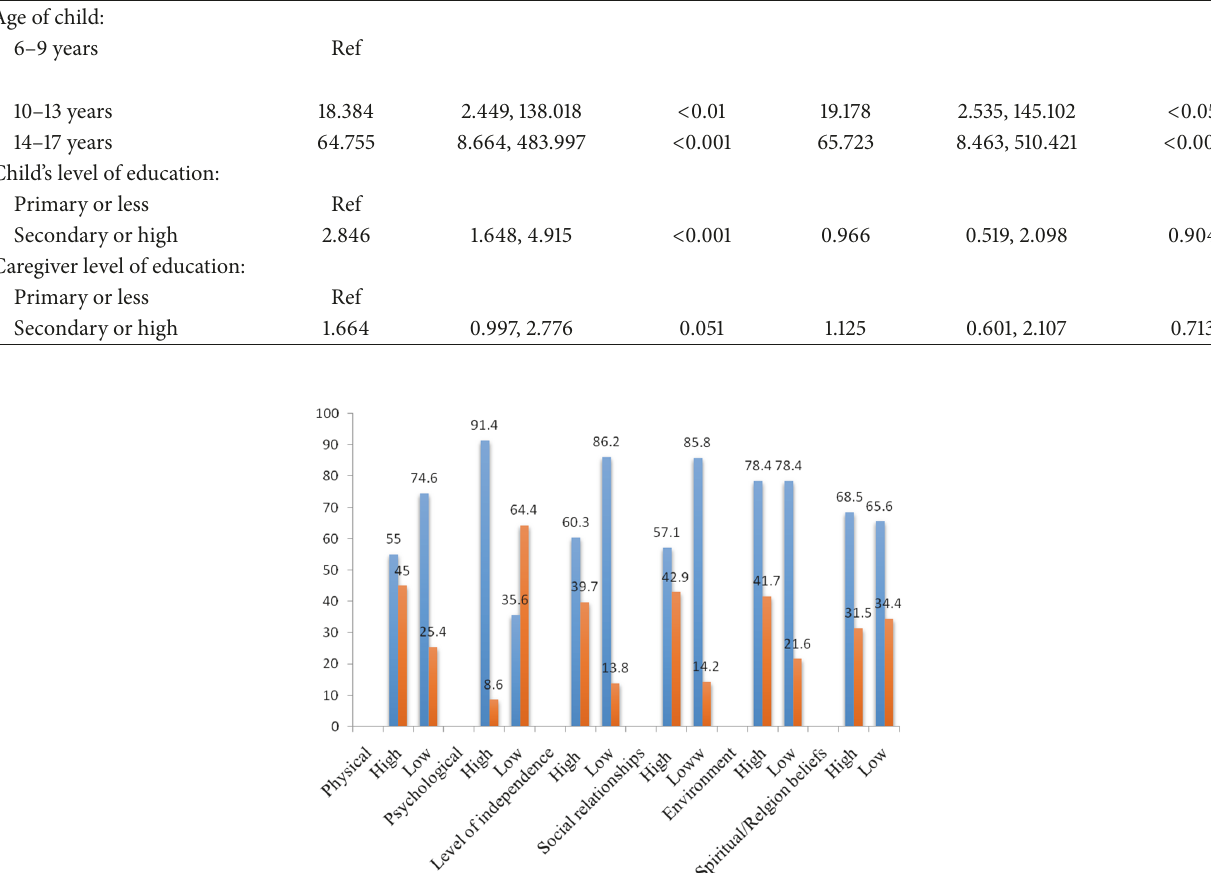
aged between 10 and 13 years and 14 and 17 years had 19 and 66 (AOR=65.755, p < 0.001) times higher odds of HIV status disclosure,